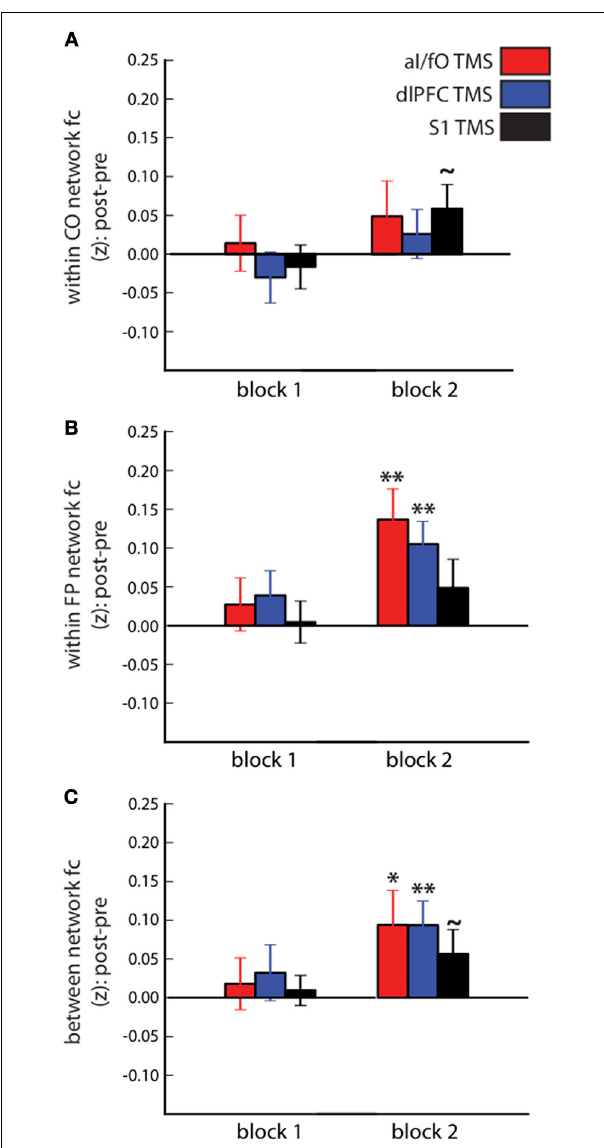
FIGURE 3 | Connectivity within and between the CO and FP networks after TBS. Changes in connectivity after TBS (post-TBS Block 1 or 2minus pre-TBS) are shown for the CO network (A) , FP network (B) , and between the two networks (C) . Different sites of TBS (red, aI/fO; blue, dlPFC; black, S1) did not have systematically different effects on within- and between-network connectivity, although connectivity generally tended to increase after TBS (Post-TBS vs. Pre-TBS: ∗∗ p < 0 . 01, ∗ p < 0 . 05, ∼ p < 0 . 10).